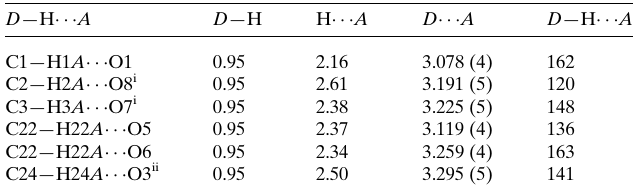
Table 1 Hydrogen-bond geometry (A˚ , (cid:4) ).